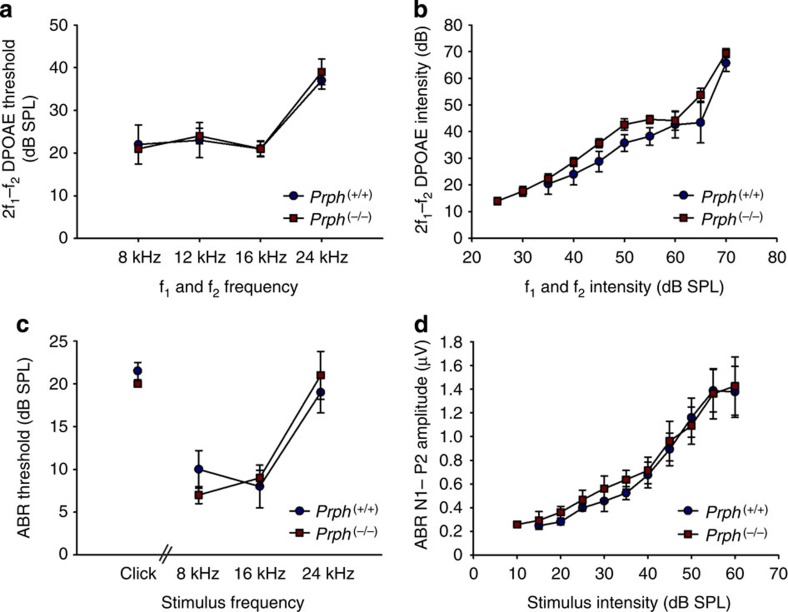
Prph(−/−) mice have baseline hearing indistinguishable from Prph(+/+) littermate mice.(a,b) Cubic (2f1–f2) distortion product otoacoustic emission (DPOAE) thresholds and 8 kHz input–output functions. (c,d) Auditory brainstem response (ABR) threshold and 8 kHz input–output functions for the N1-P2 wave, which reflects cochlear nerve recruitment (n=5). Data are shown as mean±s.e.m.; P>0.05 (SA8).